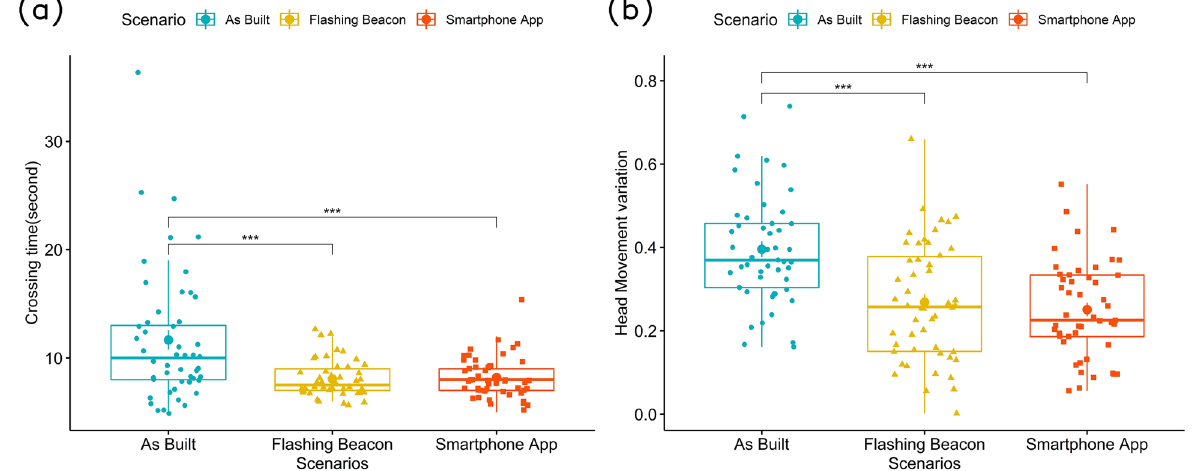
Figure 2. ( a ) Average crossing time of different scenarios; ( b ) head movement variation of different scenarios.